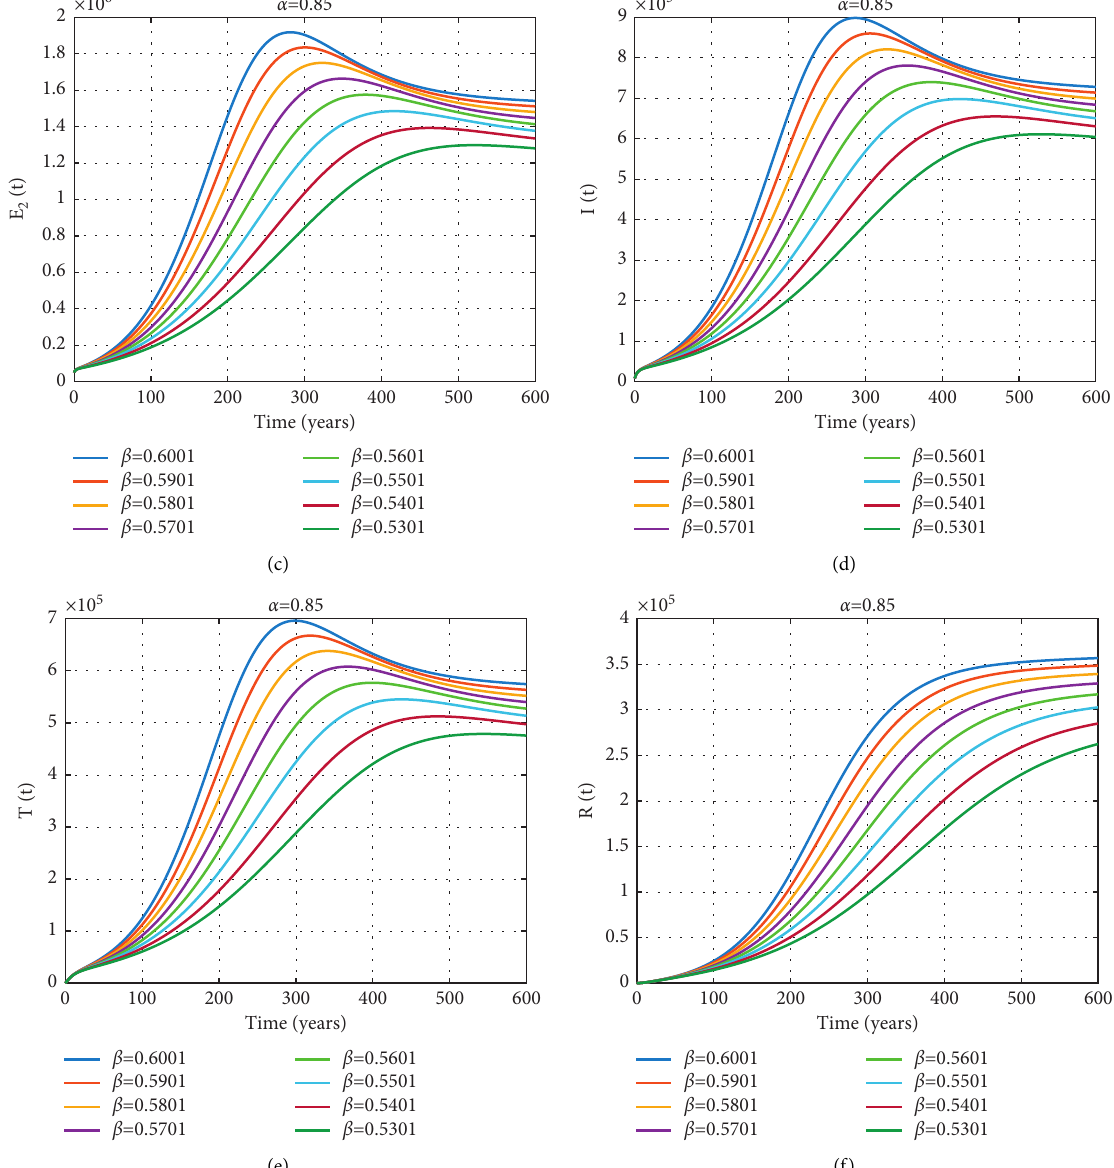
Figure 5: Behavior of the TB model with an impact of contact rate β at α � 0 .